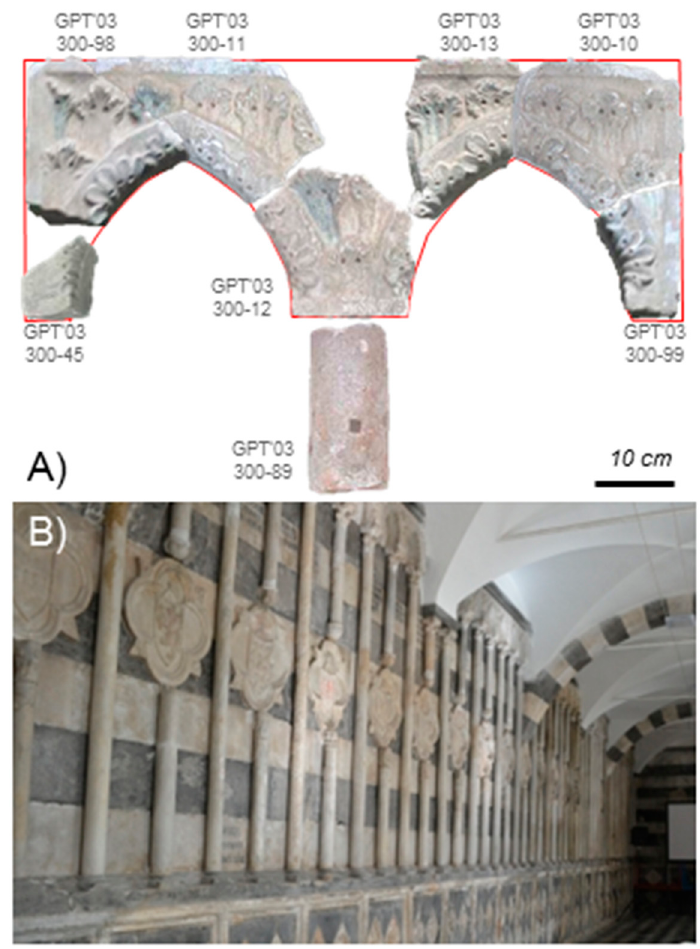
Figure 3. Function reconstruction through comparison with other parts of the building that are still intact. ( A ) Virtual reconstruction of one of the double arches from seven pieces (GPT’03 300-10, -11, -12, -13, -44, -98, -99) and one of the columns with anchorage signs on the back of the trunk (GPT’03 300-89). The photography of the fragments is courtesy of the Superintendence of Archaeology, Fine Arts and Landscape for the metropolitan city of Genoa and the provinces of Imperia, La Spezia and Savona (partial or total reproduction is forbidden without prior (written) permission). ( B ) Remains of the ambulacrum of the lower cloister characterised by a series of double arches and columns embodied in the wall, now part of the elementary school Daneo.